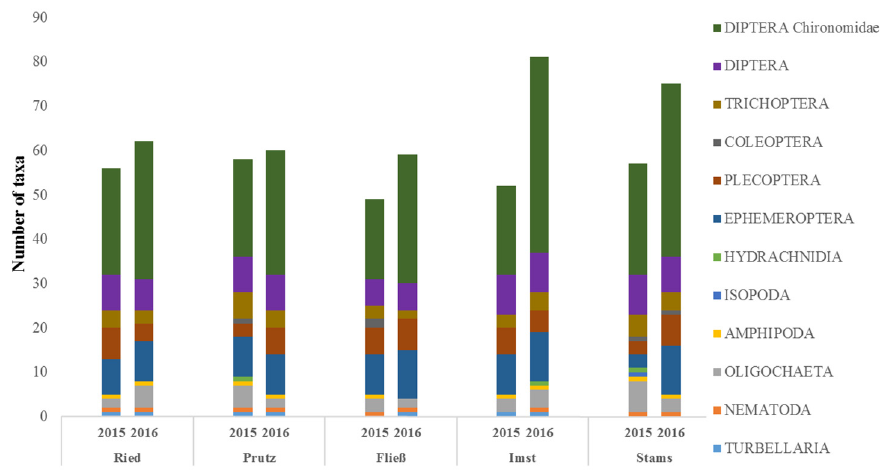
Figure 5. Taxa numbers per taxa group at each site and sampling date (November 2015 vs. March 2016).